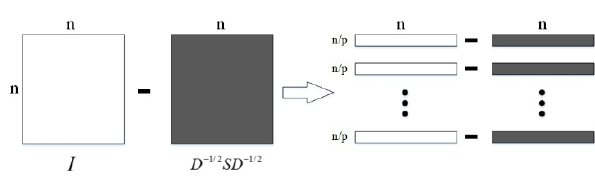
Figure 6. Multi-thread solution for constructing Laplacian